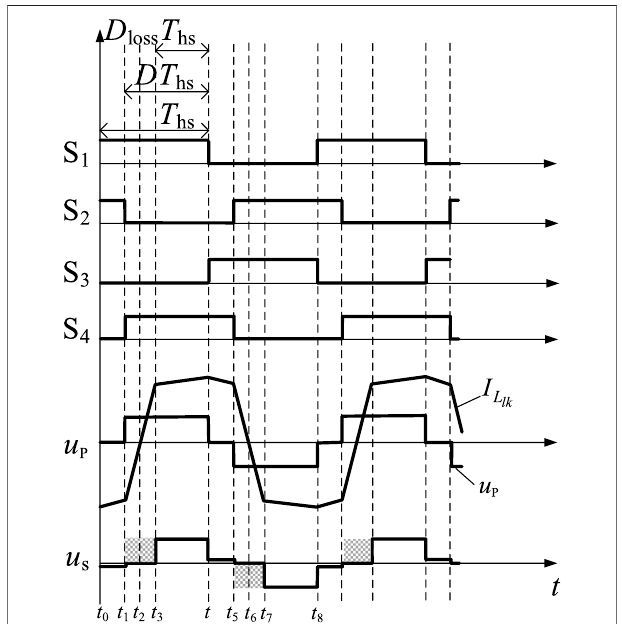
FIGURE2 | Waveform diagram ofthe working principle of phase-shifted full-bridge